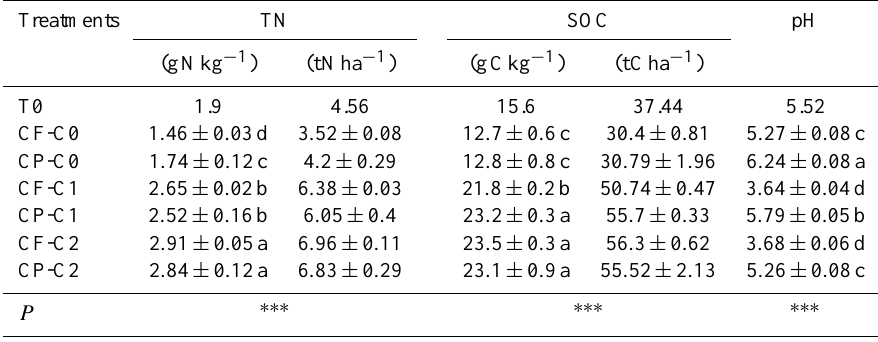
Table 2. Influence of biochar amendment on soil total nitrogen (TN), soil organic carbon (SOC) and soil pH in six different treatments over the entire experimental period. Values represent means ± SD ( n = 3).